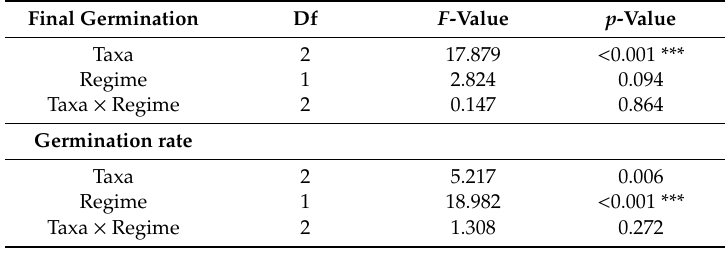
Table 1. Results of the ANOVAs comparing the e ff ects of the temperature treatments (Regime) and Alnus taxa on the final germination percentage and germination rate ( t50